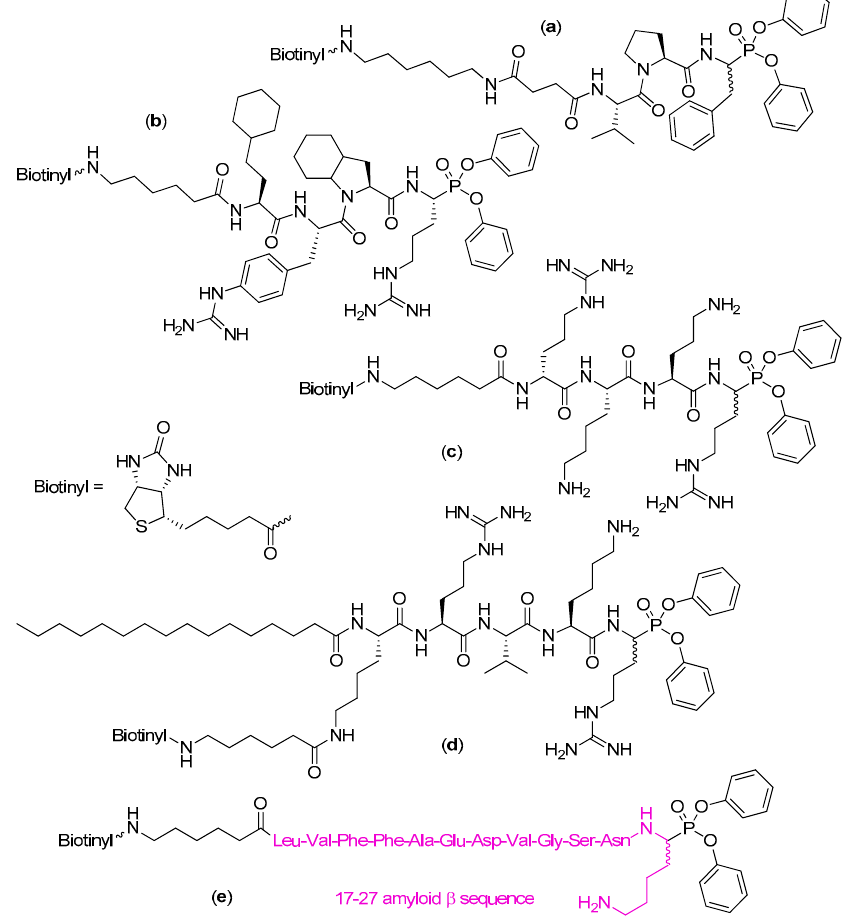
Figure 5. Highly potent and specific activity-based-probes with the diphenyl phosphonate warhead and biotin reporter for detection of serine protease activity of cathepsin G ( a ), human neutrophil serine protease 4 ( b ), the structure developed with the use of HyCoSuL methodology), the Zika virus NS2B-NS3 protease ( c ), furin ( d ), and amyloid β peptide-hydrolyzing antibodies ( e ).